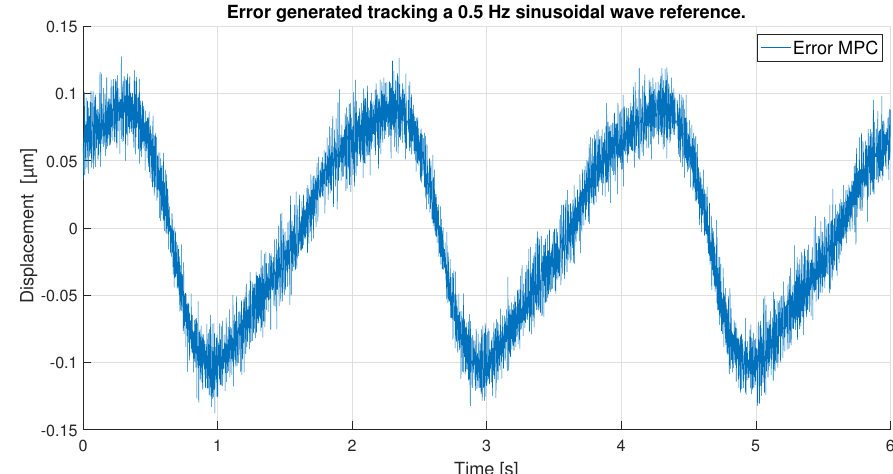
Figure 21. Error of tracking of the MPC for a 0.5 Hz sinusoidal reference.